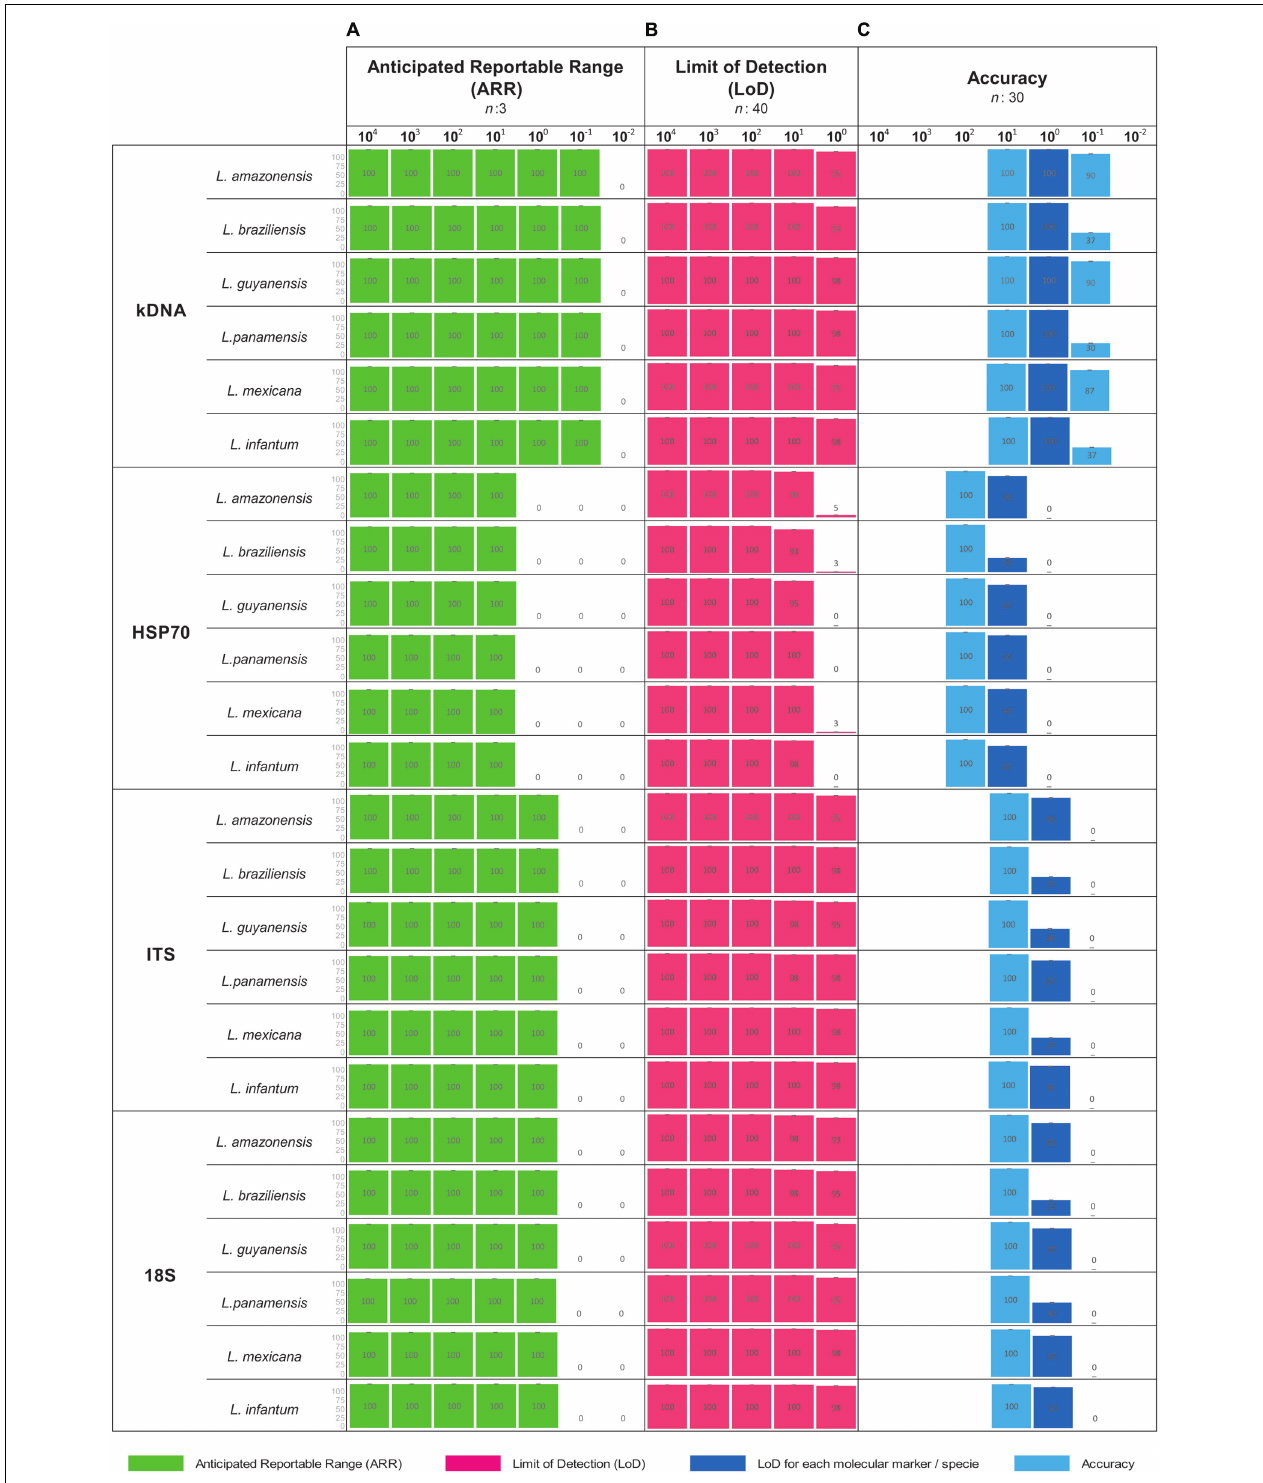
FIGURE 1 | Analytical sensitivity for conventional PCR. For each concentration a result is determined as positive when band presence was observed. (A) ARR determined from 7 serial dilutions analyzed for the four markers employed across the seven species studied; (B) LoD as a consensus of 5 serial dilutions for the four markers employed across the seven species studied and (C) Accuracy. Including dilution above and below the LoD for the four markers employed across the seven species studied.